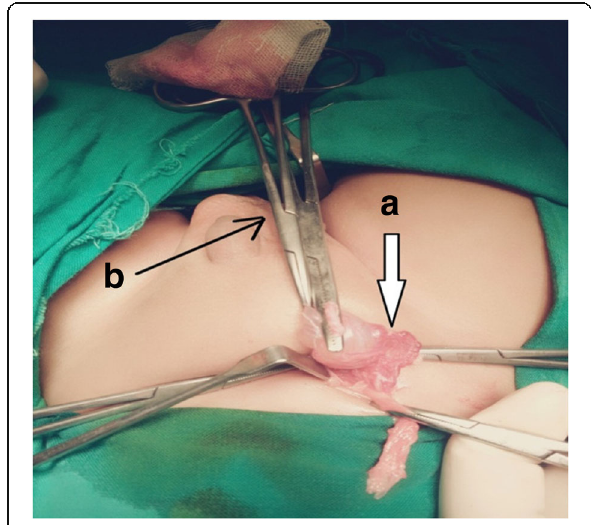
Fig. 11 Photograph of a 9-month-old male infant showing hydrocele (b arrow) who was operated to close surgically the hernia sac (arrow